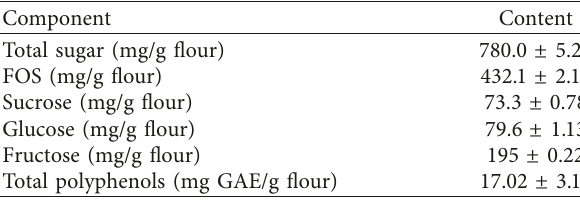
Table 1: Chemical characterization of yacon